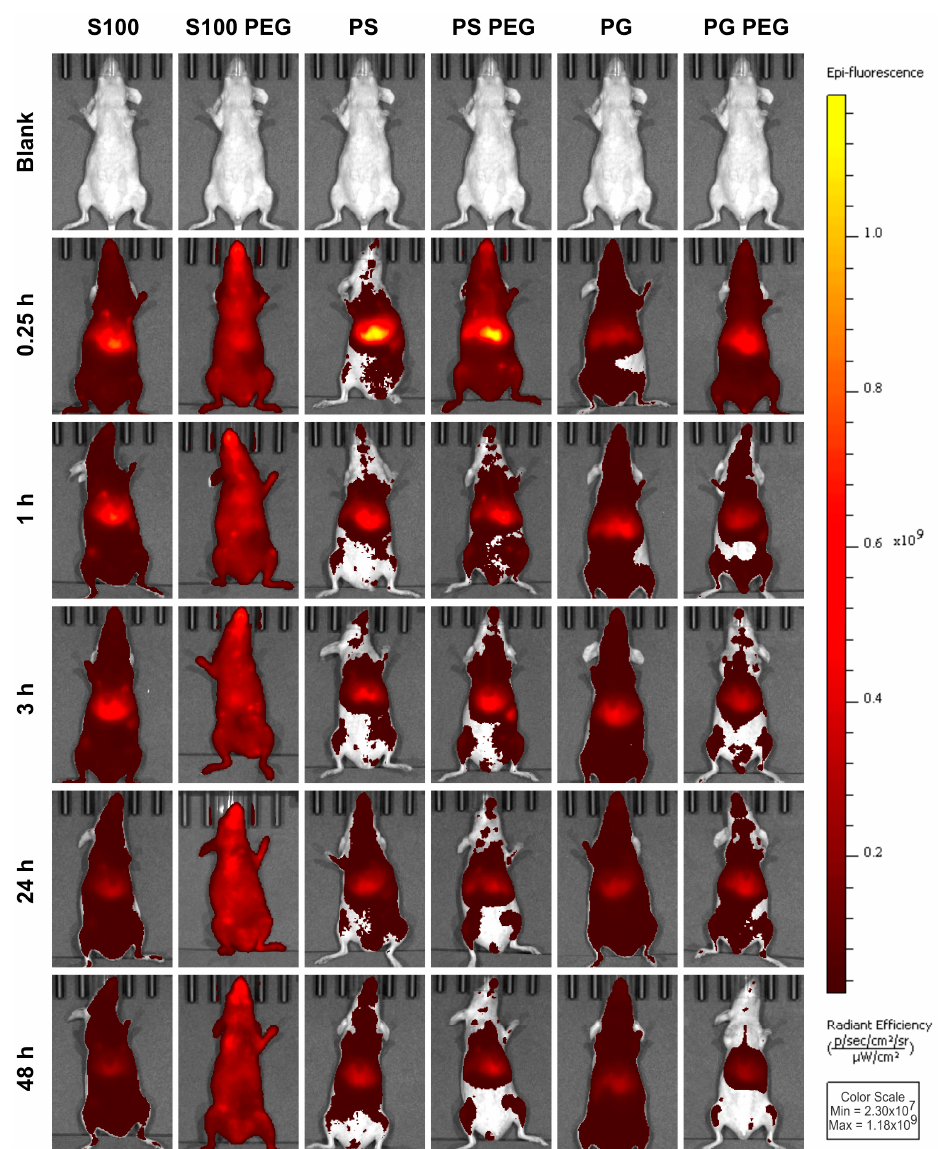
Figure 2. In vivo liposome pharmacokinetics differed in distribution and abdominal accumulation, depending on both formulation and PEGylation. DiR-loaded liposome-treated female mice (ventral perspective), as assessed by in vivo fluorescence imaging (FI). The total radiant efficiency (TRE) of representative mice of each group and time points is shown. For direct comparison, radiant efficiency was normalized.